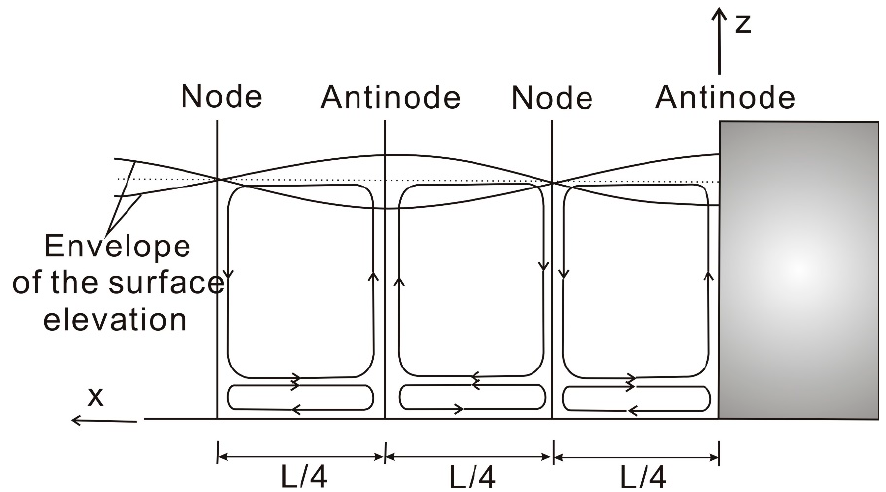
Figure 6. The pattern of steady boundary layer streaming in the vertical plane under the standing waves (reproduced from [9]).